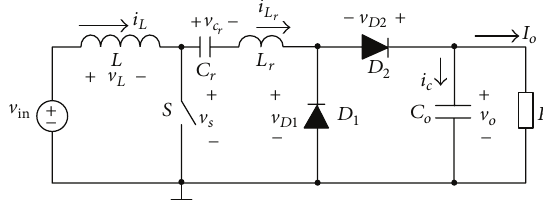
Figure 1: The topology of Bipolar-Gain Pseudo-Boost